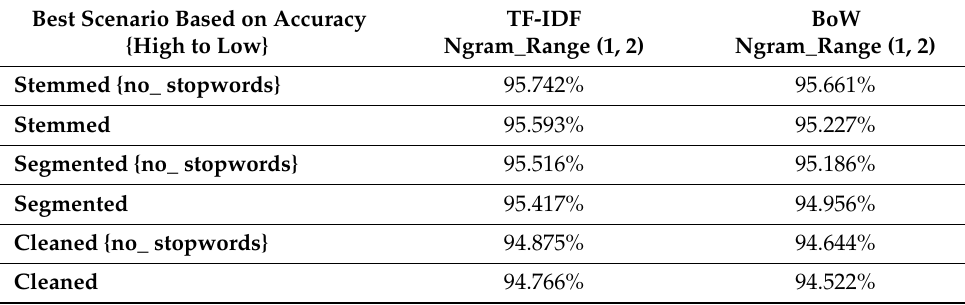
Table 2. Summary of best accuracy results of extracted scenarios.